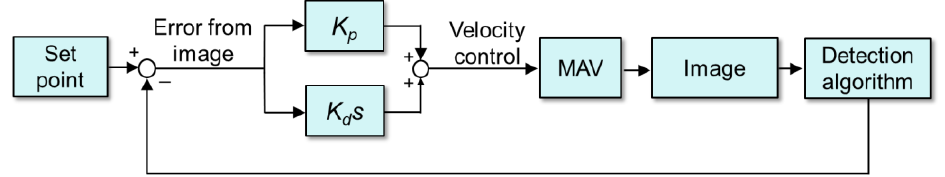
Figure 3. MAV PD control.